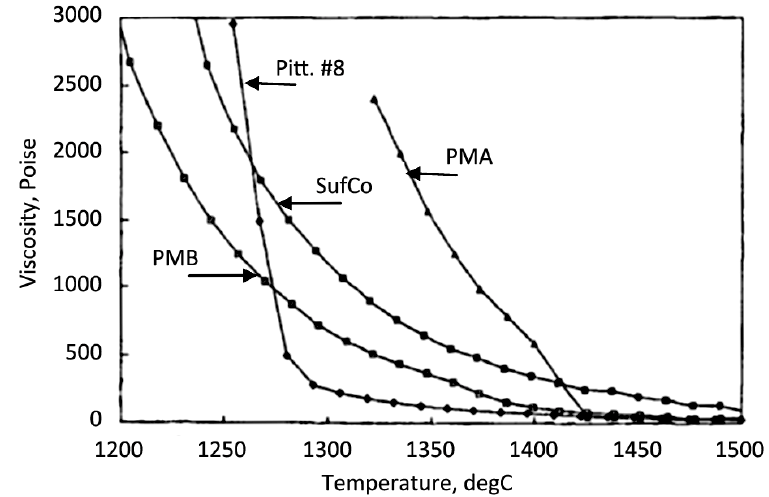
Figure 6. Slag viscosity changes with temperature